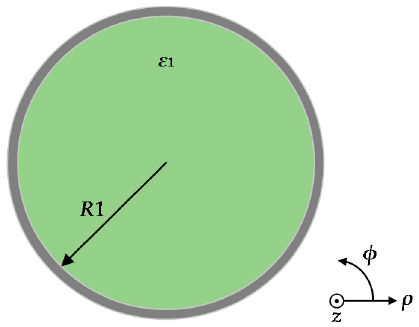
Figure 1. Schematic illustration of the graphene-coated dielectric nanowire waveguide.